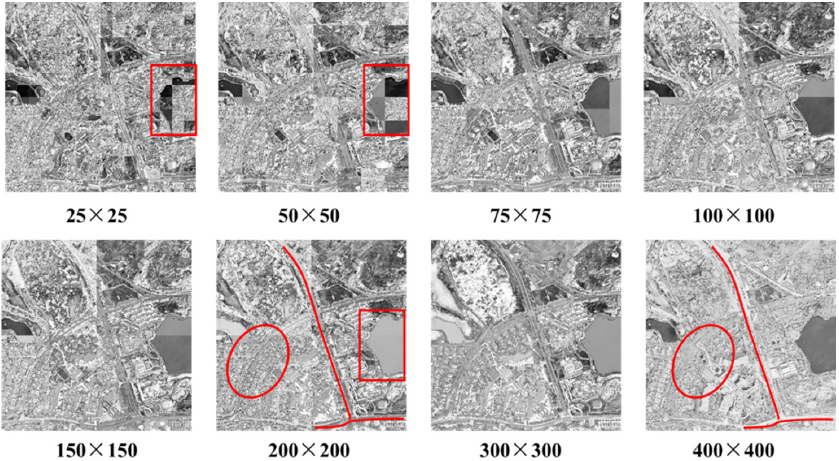
Figure 11. The weight parameter image of the Wuhan TM image for different patch sizes (refer to the text for a detailed description of the markup).